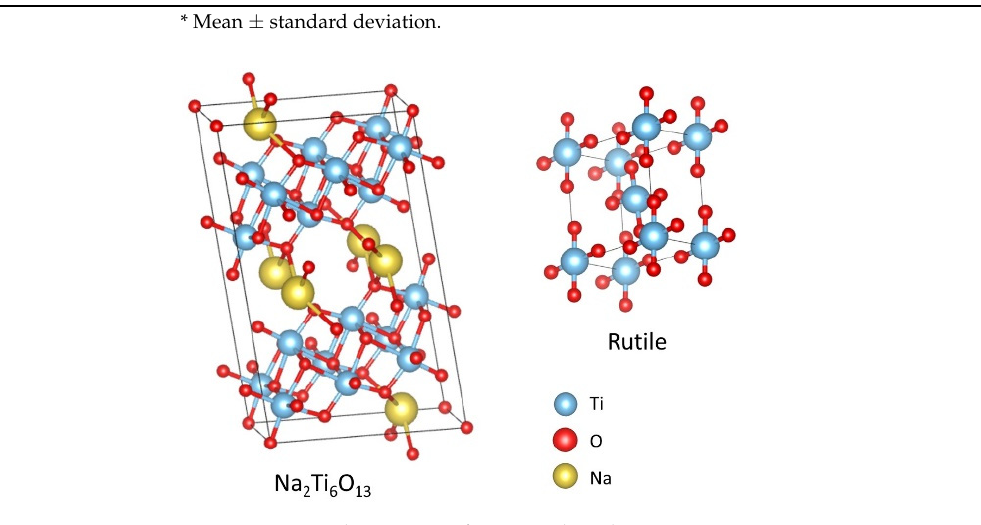
Table 2. Percentage of phase composition and Rietveld refinement parameters of the samples.